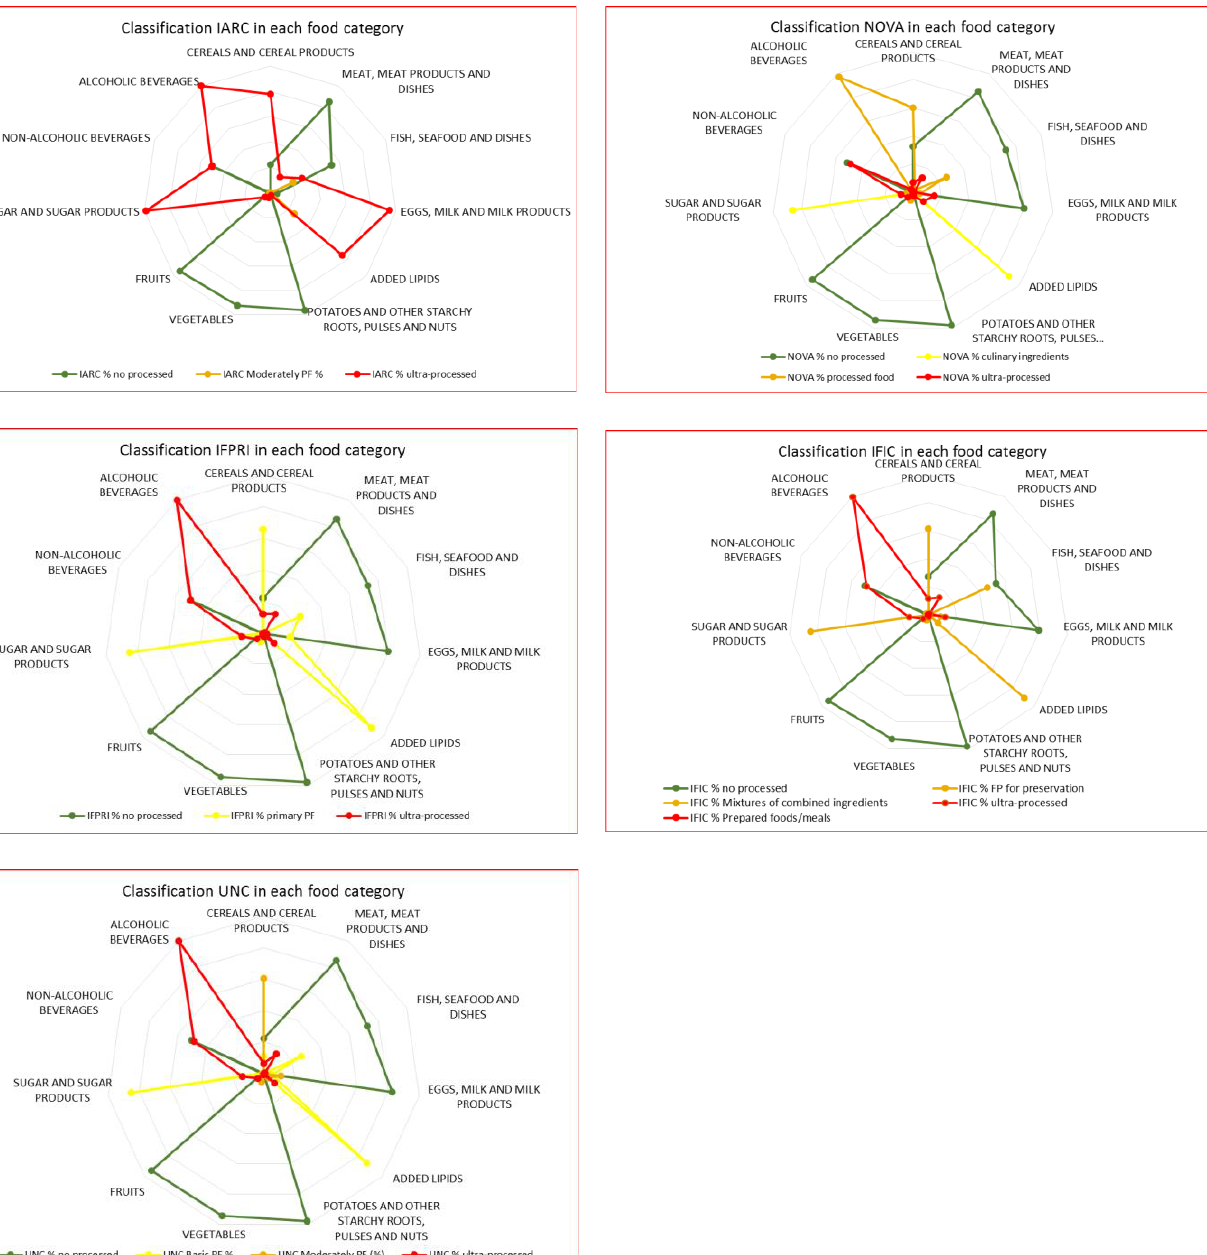
Figure 1. Comparison among food processing classification systems: percentage contribution of their different degree of processing groups by food and beverages categories — Portuguese house- different degree of processing groups by food and beverages categories—Portuguese household hold budget survey, 2000. budget survey,